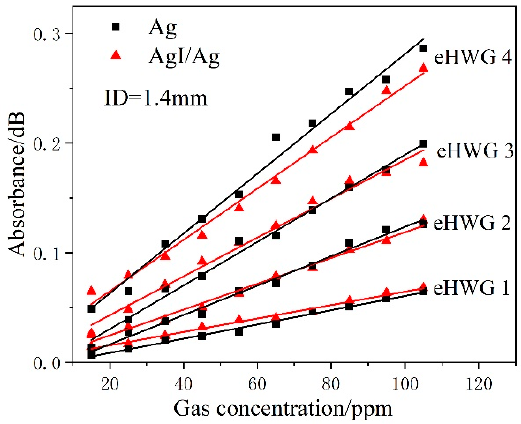
Figure 8. Absorbance vs. gas concentration for the eHWGs with an Ag or AgI/Ag waveguide. Table 2. Performances for eHWG with an Ag or AgI/Ag waveguide (ID = 1.4 mm).